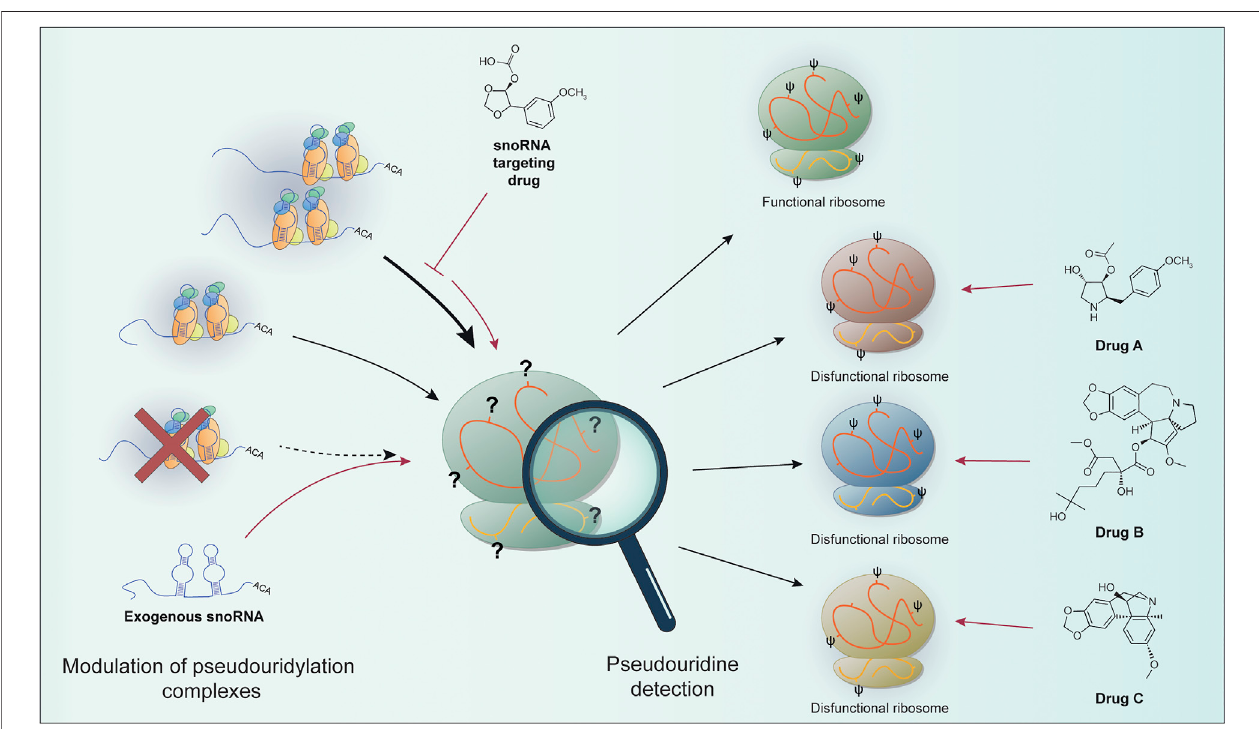
FIGURE1| Thelevelsofsite-speci fi cpseudouridylationcanbeaffectedbyalterationsinthecomponentsofthepseudouridylationcomplex(e.g.,re-modulation on snoRNA expression or pseudouridine core proteins impairment). snoRNA-based targeted therapies (e.g., snoRNA targeting drugs or exogenous snoRNA sequences) can in principle restore proper rRNA modi fi cation. Site-speci fi c pseudouridine detection can allow the identi fi cation of particular ribosomal populations. These features canbeexploitedtodevelopdrugstargetingspeci fi cribosomalpositionscontainingdysregulatedpseudouridinesites.Itcouldbethenpossibletotakeadvantageof thispeculiarityincancertotargetonlythecellswithmodi fi edribosomes,thesocalled “ oncoribosomes ” .Prospectively,thecharacterizationofribosomemodi fi cations(or snoRNA expression as a surrogate) can be used to speci fi cally target cancer